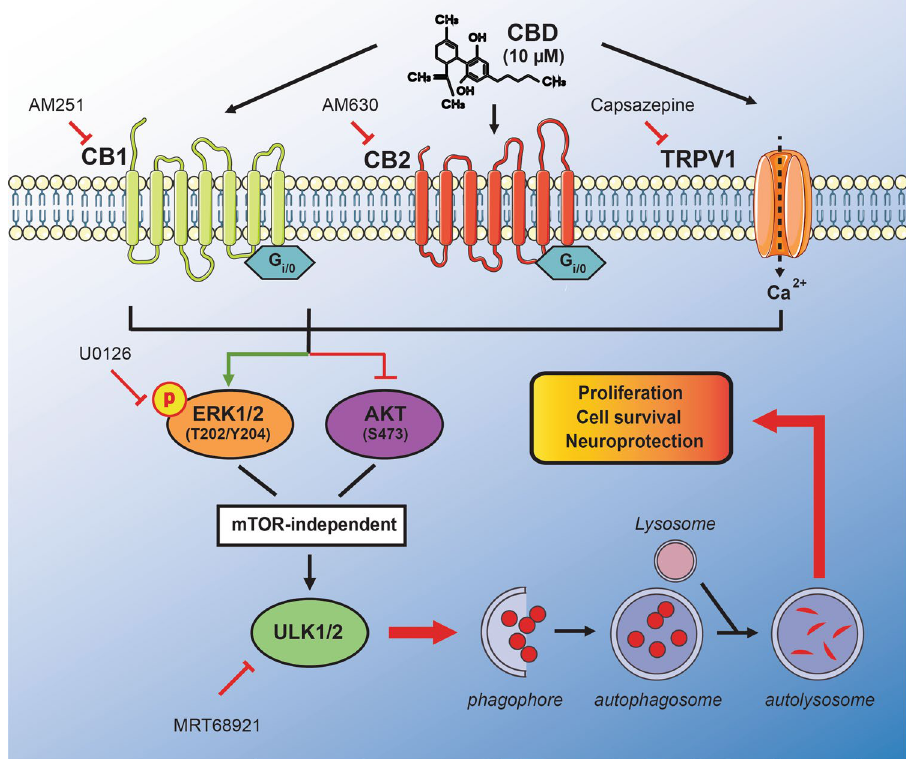
Figure 6. Schematic representation of the signaling pathway mediated by CBD in SH-SY5Y cells. At 10 µM, CBD activates autophagy, resulting in the accumulation of LC3-II and increased presence of LC3-positive puncta. AM 251, AM 630 and CPZ antagonists abrogated the observed LC3-II accumulation, thus implicating canonical cannabinoids (CB1 and CB2) and TRPV1 receptors in CBD-mediated autophagy. Additionally, CBD activated the ERK1/2 signaling cascade by increasing phosphorylation at Tyr204/Thr202 after 10 min of CBD treatment but suppressed the PI3K/AKT pathway by reducing AKT phosphorylation at S473. On the other hand, CBD treatment did not change AMPK phosphorylation at Thr172 or the phosphorylation levels of autophagy-related proteins ULK1 (Ser757) and p70S6K (Thr389). In conclusion, our findings suggest that CBD-induced autophagy activation is dependent on ULK1 and occurs in an mTORC1 independent-manner. Furthermore, the effects on the ERK1/2 and PI3K/AKT pathways, which regulate cell survival and proliferation, indicate that CBD could elicit neuroprotective actions. The illustration was produced using smart servier medical art vectors for publications and presentations licensed under the Creative Commons (CC BY 3.0) available at